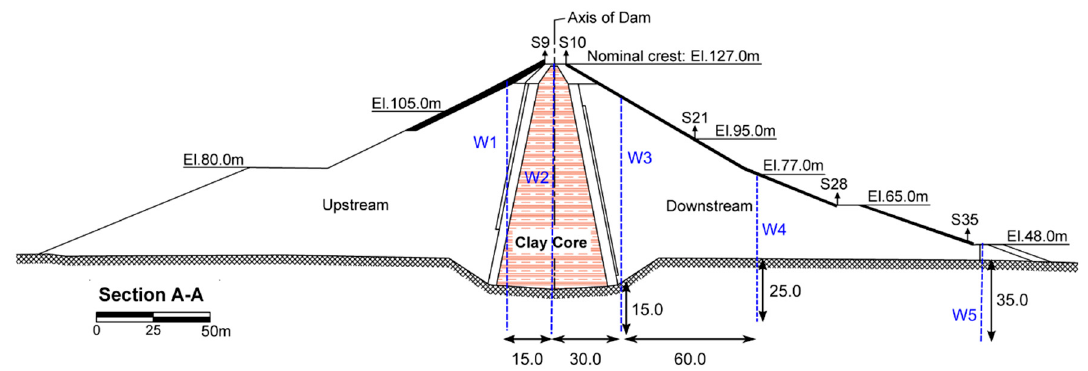
Figure 12. Location of piezometers W1–W5 along cross-section A-A.